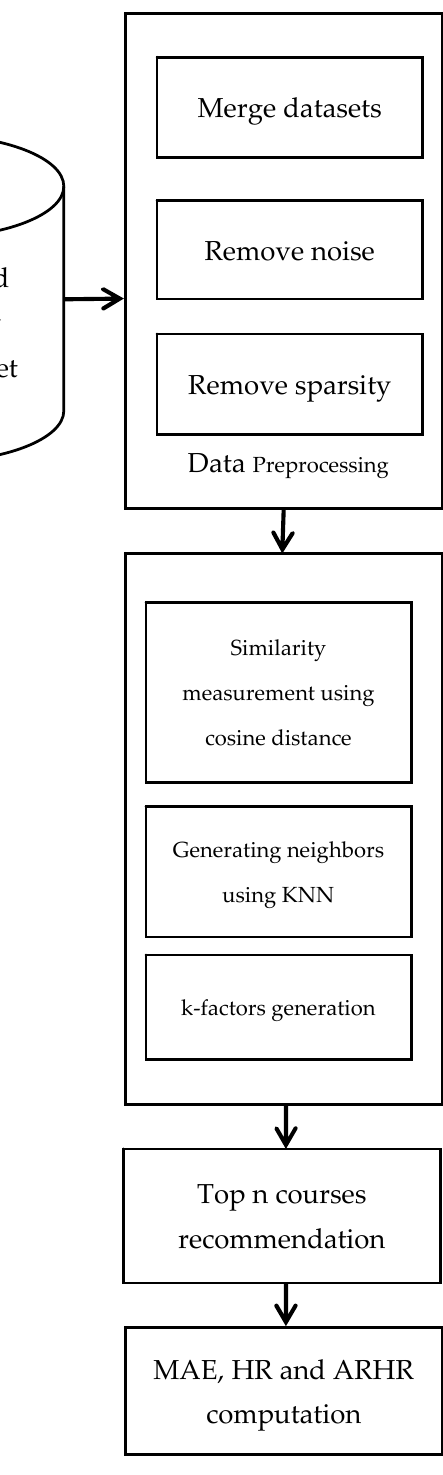
Figure 2. Workflow diagram of KNN.